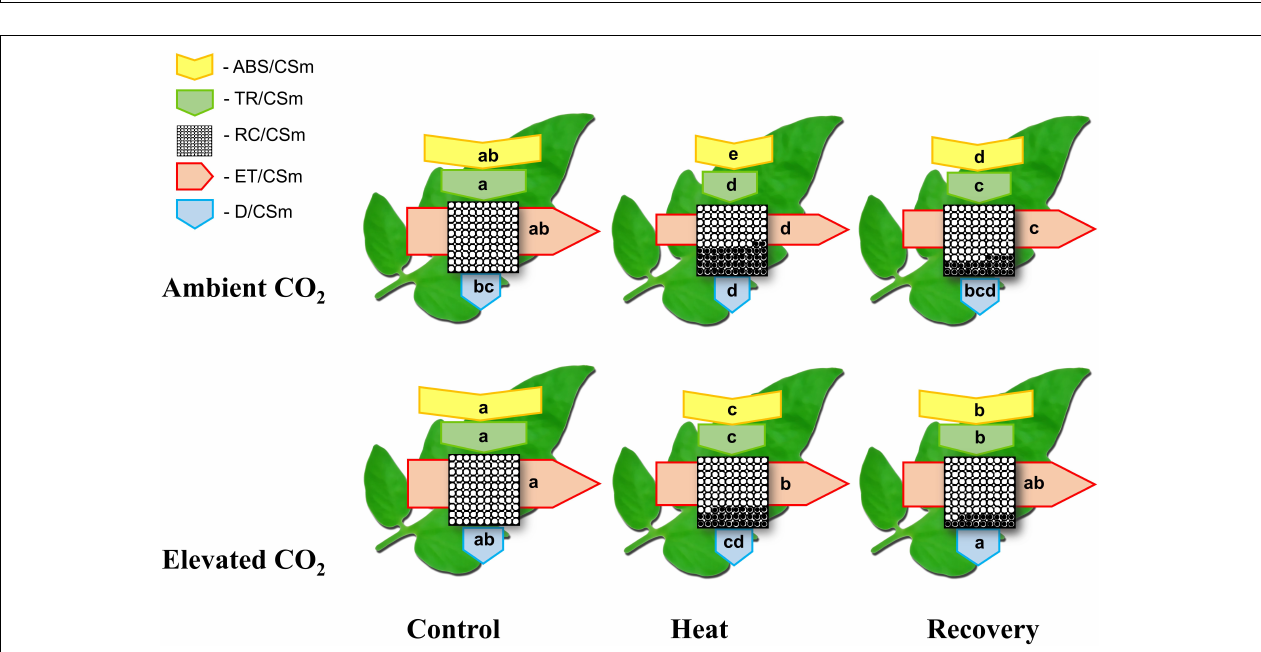
FIGURE 3 | Energy pipeline leaf model of phenomenological fluxes (per cross section, CS) in the third fully expanded leaf in tomato as influenced by elevated CO 2 and heat stress. The results are expressed as the mean values ± SD, n = 6. Each relative value is drawn by the width of the corresponding arrow, standing for a parameter. Different letters within the same color arrows indicate significant differences at P < 0.05 according to Tukey’s test. Empty and full black circles indicate, respectively, the percentage of active (QA reducing) and non-active (non-QA reducing) reaction centers of photosystem II (PSII); ABS/CSm, the absorption flux per cross section; TR/CSm, the trapped energy flux per PSII cross section; ET/CSm, the electron transport in PSII cross section; D/CSm, the energy dissipation per PSII cross section; and RC/CSm, the density of active reaction centers.